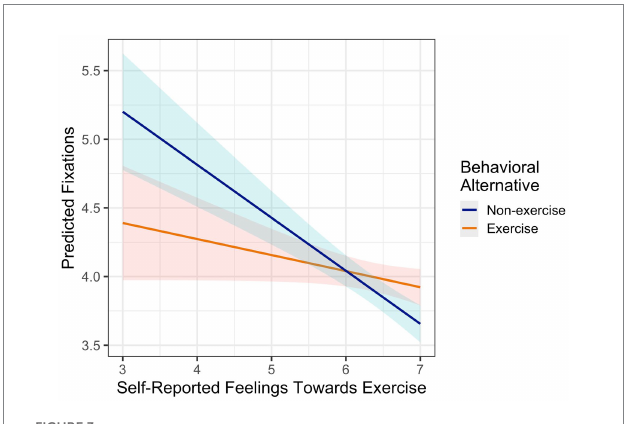
FIGURE 3 Predicting fixations on the exercise (orange) and non-exercise alternative (blue) with self-reported feelings towards